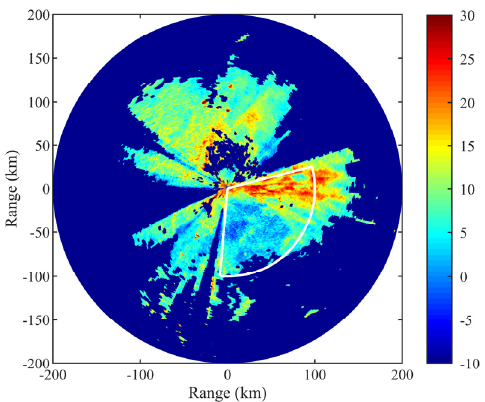
Figure 11. A PPI map of the equivalent reflectivity factor (dBZ) measured by a Doppler weather radar situated in Qingdao.